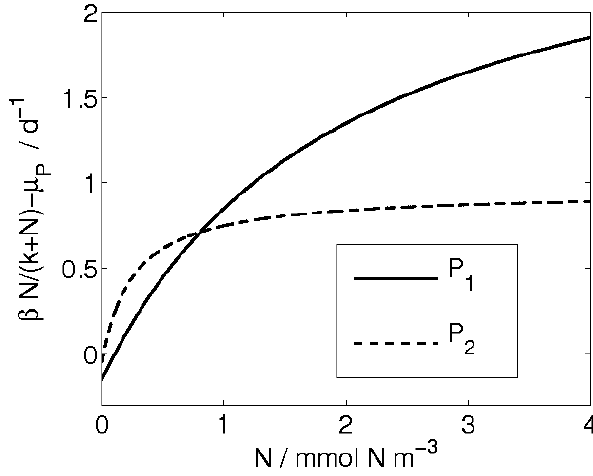
Fig. 2. Effective growth rate (growth minus mortality neglecting the grazing by zooplankton) of the two different phytoplankton groups dependent on available nutrients. Intersection at N = 0 . 81 mmolN